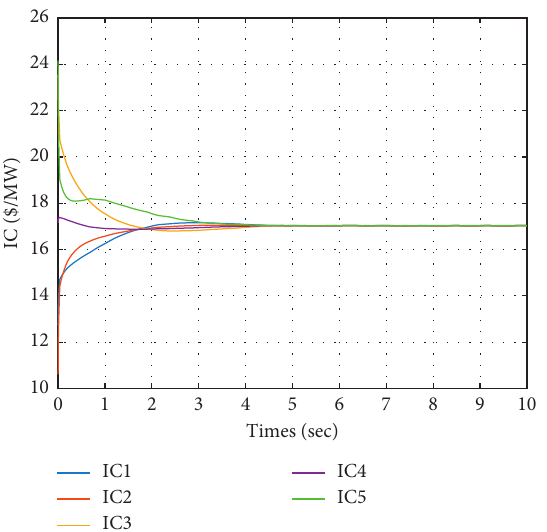
i with power gen-